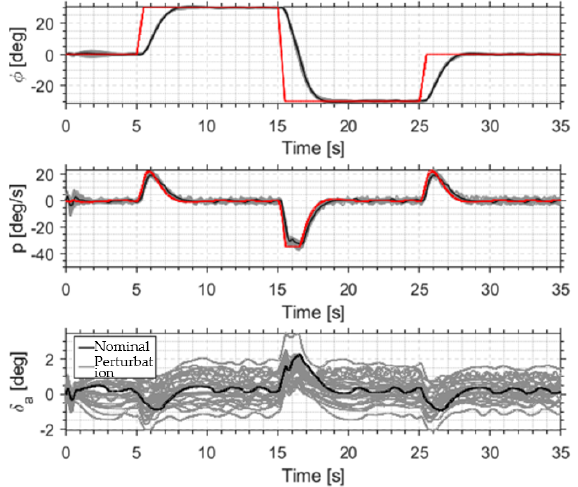
Figure 20. Perturbation simulation of the roll channel at 9 km altitude and 0.7 Mach